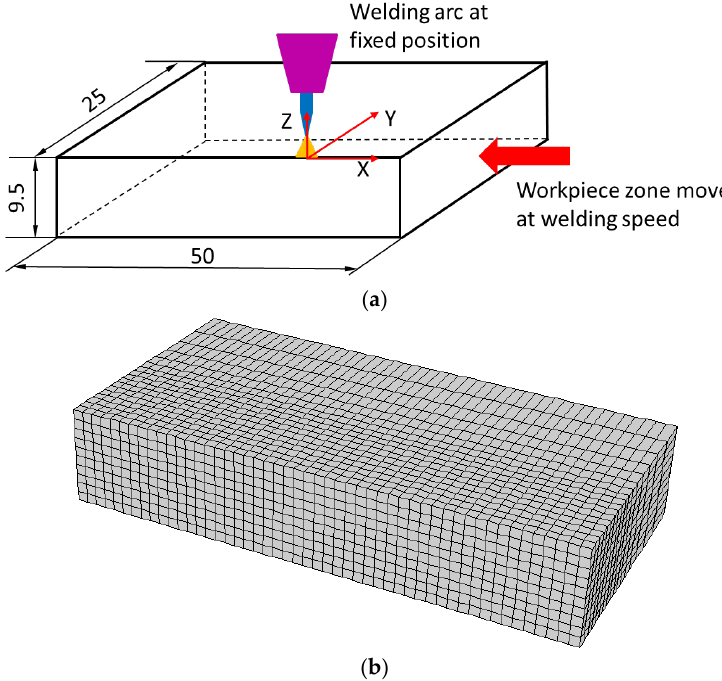
Figure 3. Dimensions of computation domain and the mesh used in CFD (unit: mm): ( a ) dimensions of the computation domain; and ( b ) mesh divisions in CFD.